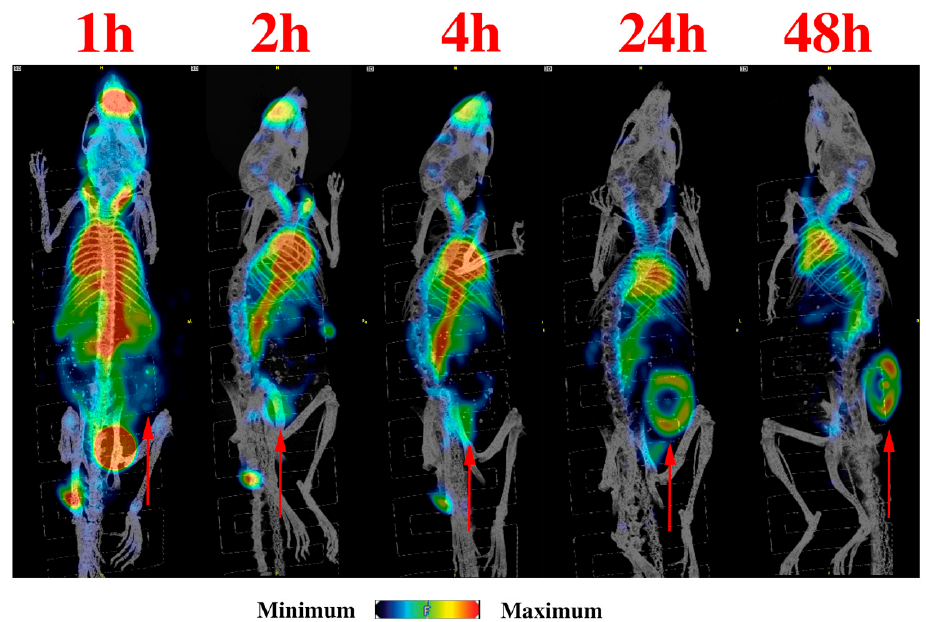
Figure 1. microSPECT/CT imaging of 111 In-h8C3 in B16-F10 tumor-bearing mice. The red arrows indicate tumor location. Images presented are presented as maximum intensity projections (MIP) for clarity. Slice imaging of the 24 h time point is shown in Figure S2 to show tumor location more clearly.